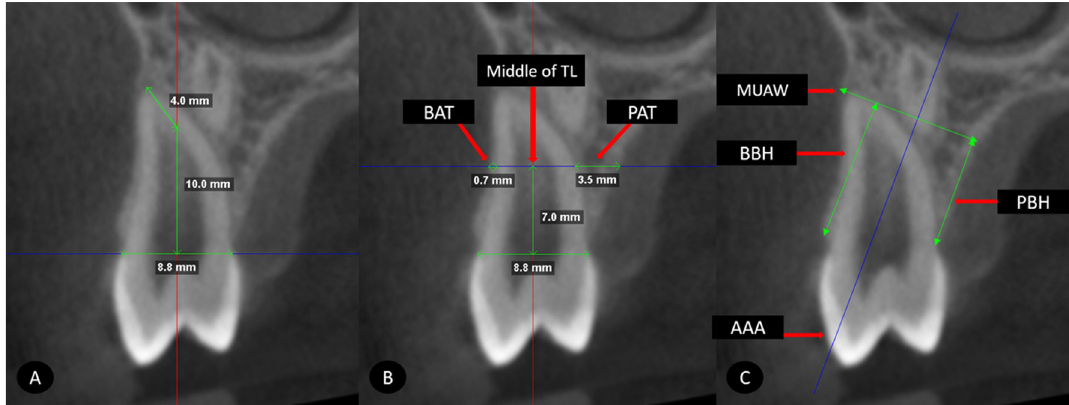
Fig 6. Measurements of alveolar bone. A, Location of PAMIC. B, (Middle of TL), buccal alveolar thickness (BAT) and palatal alveolar thickness (PAT). C, location of the alveolar axial axis (AAA), maximum upper alveolar width (MUAW), buccal bone height (BBH) and palatal bone height (BPH).